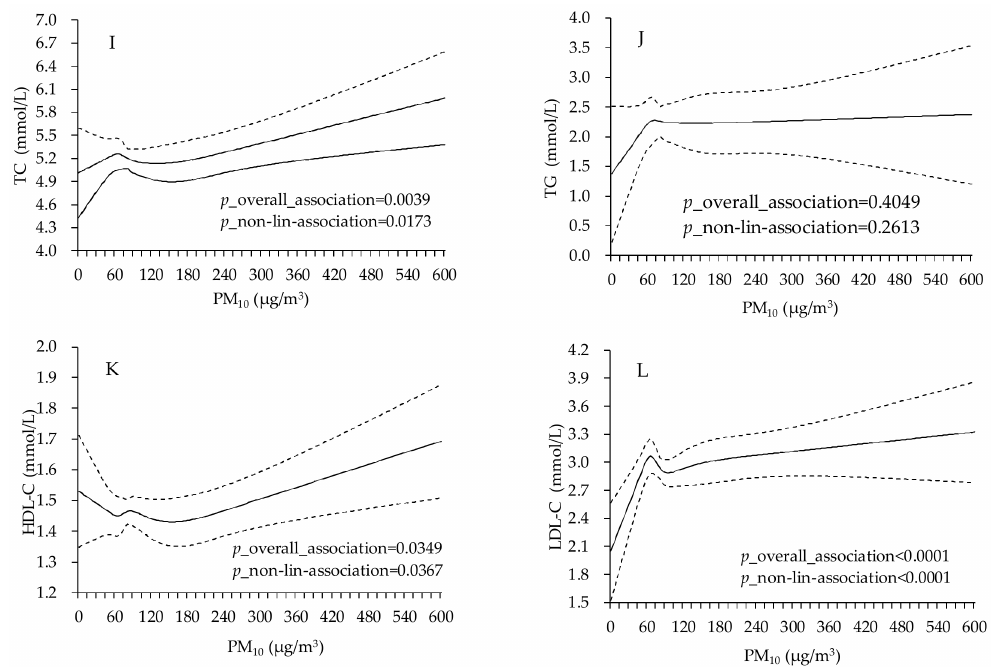
Figure 3. Adjusted dose-response association between PM 10 , SO 2 , NO 2 and lipid profiles among type 2 diabetes patients in Jinchang, China ( n = 3912). Adjusted for age, sex, education, smoke status, alcohol drink, occupation, BMI and FPG fitted simultaneously. ( A – D ) represent the dose-response association between SO 2 and TC, TG, HDL-C and LDL-C; ( E – H ) represent the dose-response association between NO 2 and TC, TG, HDL-C and LDL-C; ( I – L ) represent the dose-response association between PM 10 and TC, TG, HDL-C and LDL-C; Solid lines present the predicted values of lipid levels in different concentration of air pollutants. Dashed lines are 95 percent confidence intervals.